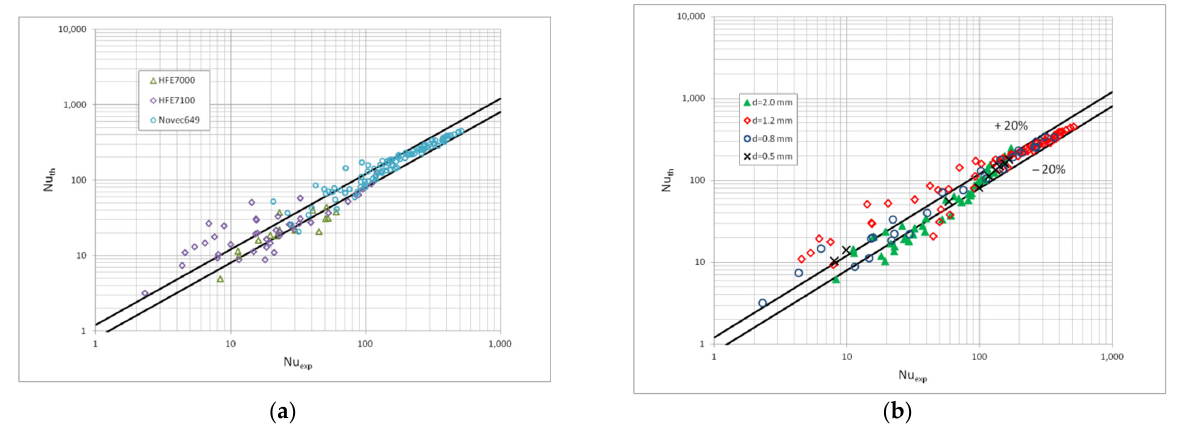
Figure 11. Comparison of the experimental investigation results of the HFE7000, HFE7100 and Novec649 refrigerants condensation in mini-channels which calculation according to the correlation (1) for the stratified flow; ( a ) for individual refrigerants, ( b ) for individual mini-channel diameters. Figure 12. Comparison of the experimental investigation results of the HFE7000, HFE7100 and Novec649 refrigerants condensation in mini-channels which calculation according to the correla- tion (1) for the intermittent flow; ( a ) for individual refrigerants, ( b ) for individual mini-channel diameters.